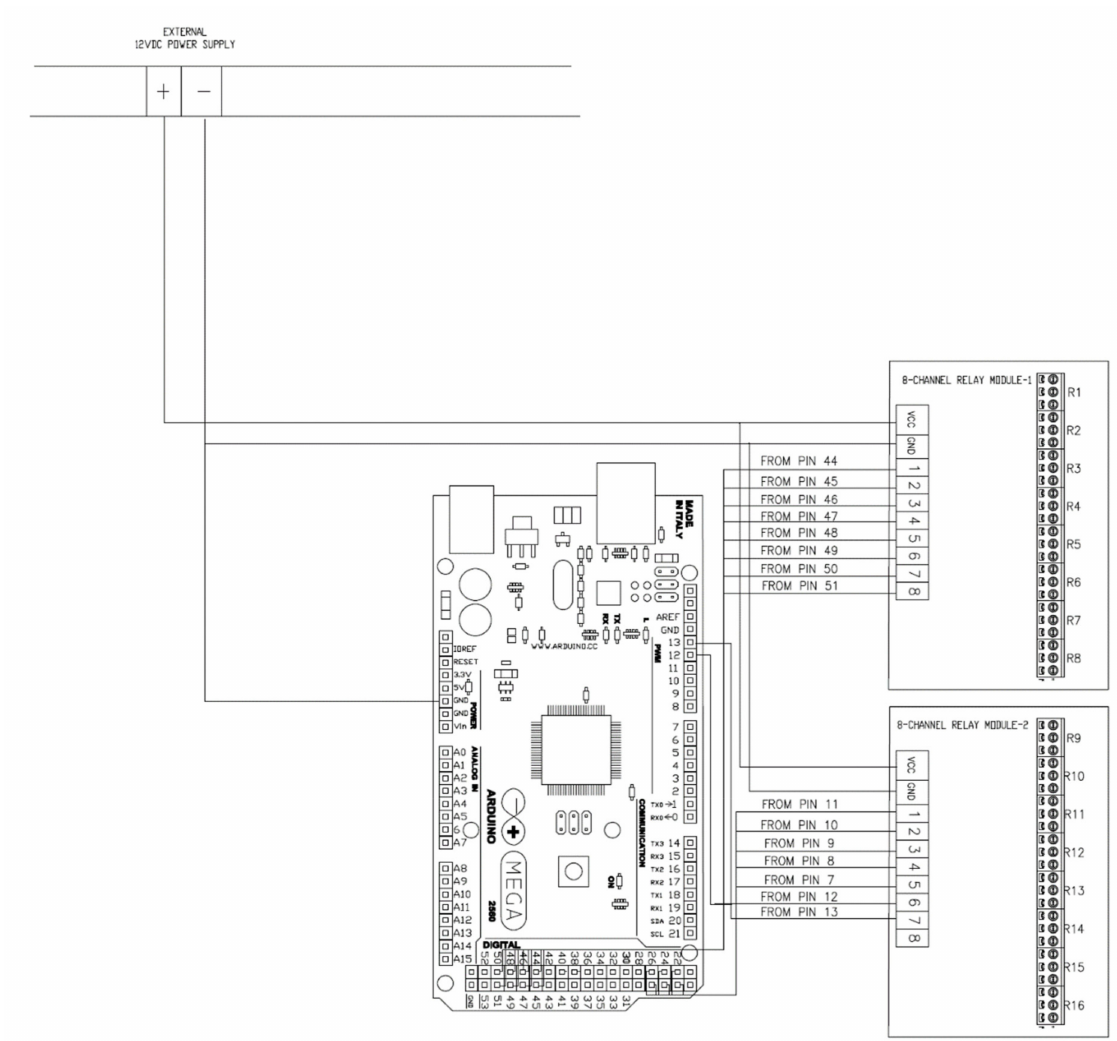
Figure 15. Power supply, Duinotech MEGA 2560, and relay modules